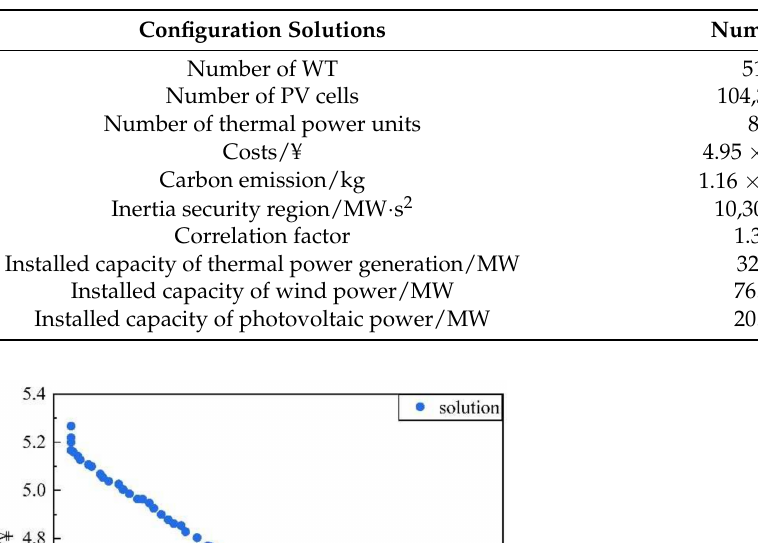
Table 2. Optimal capacity configuration solution.